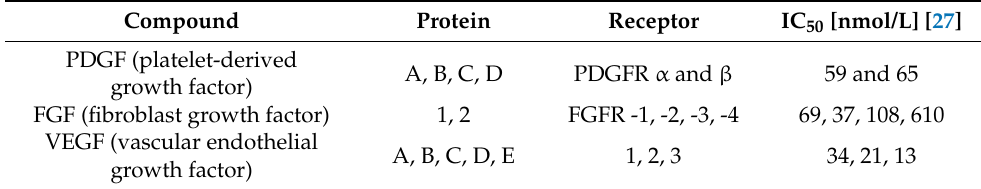
Table 1. Nintedanib’s mechanism of action